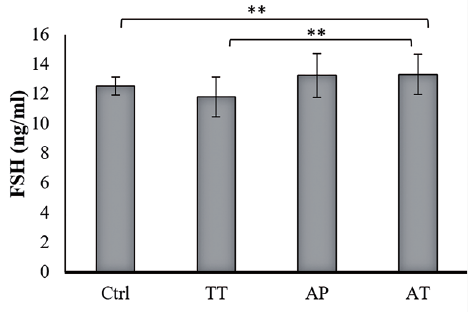
Figure 4- Effect of AP, TT and AT extract on serum level of FSH (mean ±